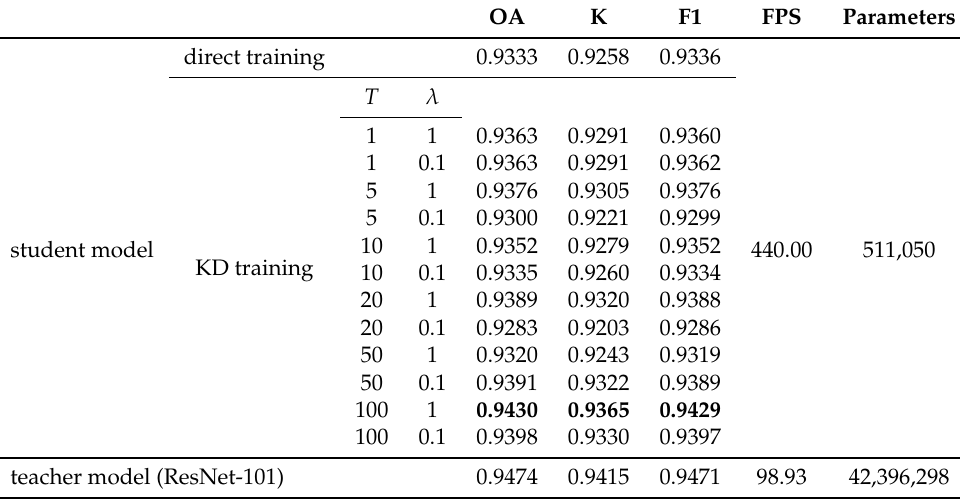
Table 9. Results of Knowledge Distillation training experiments on EuroSAT